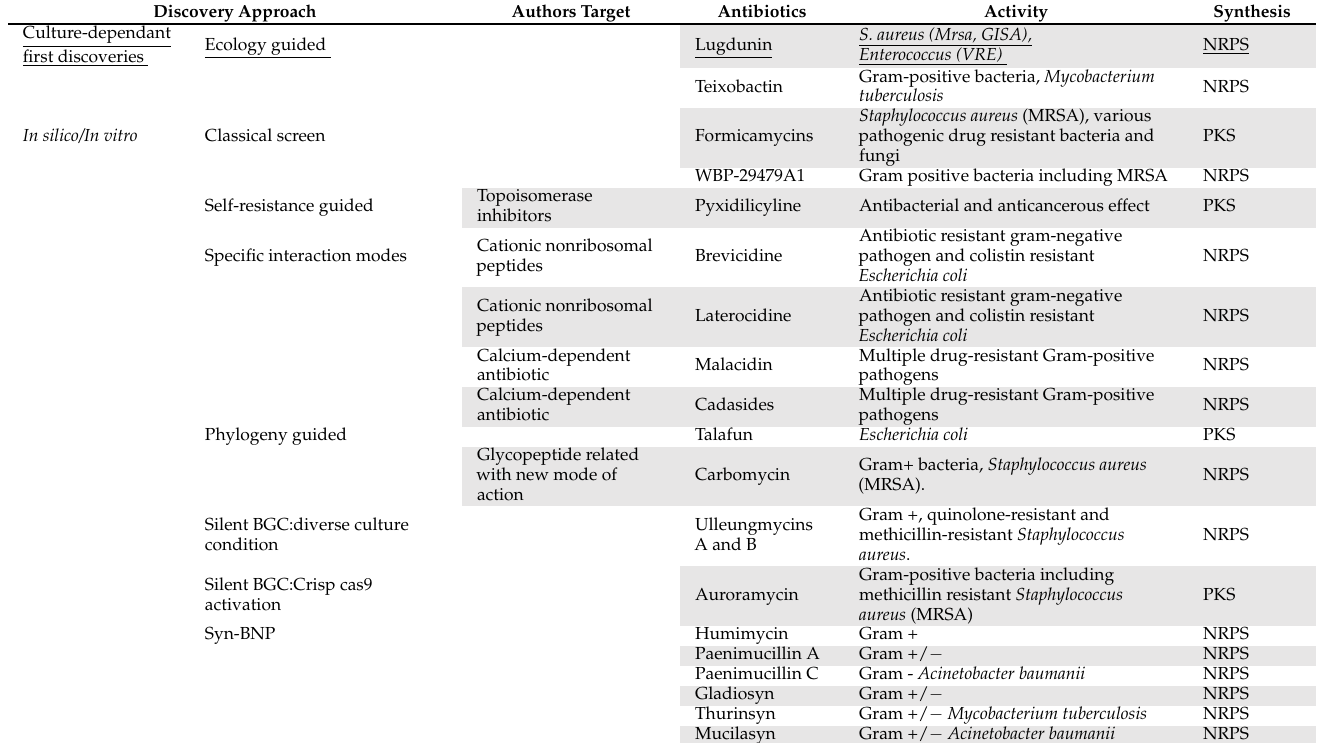
Table 2. New Nonribosomal peptide (NRP) and polyketide (PK) products discovered by foreign in silico/in vitro strategies. Discovery